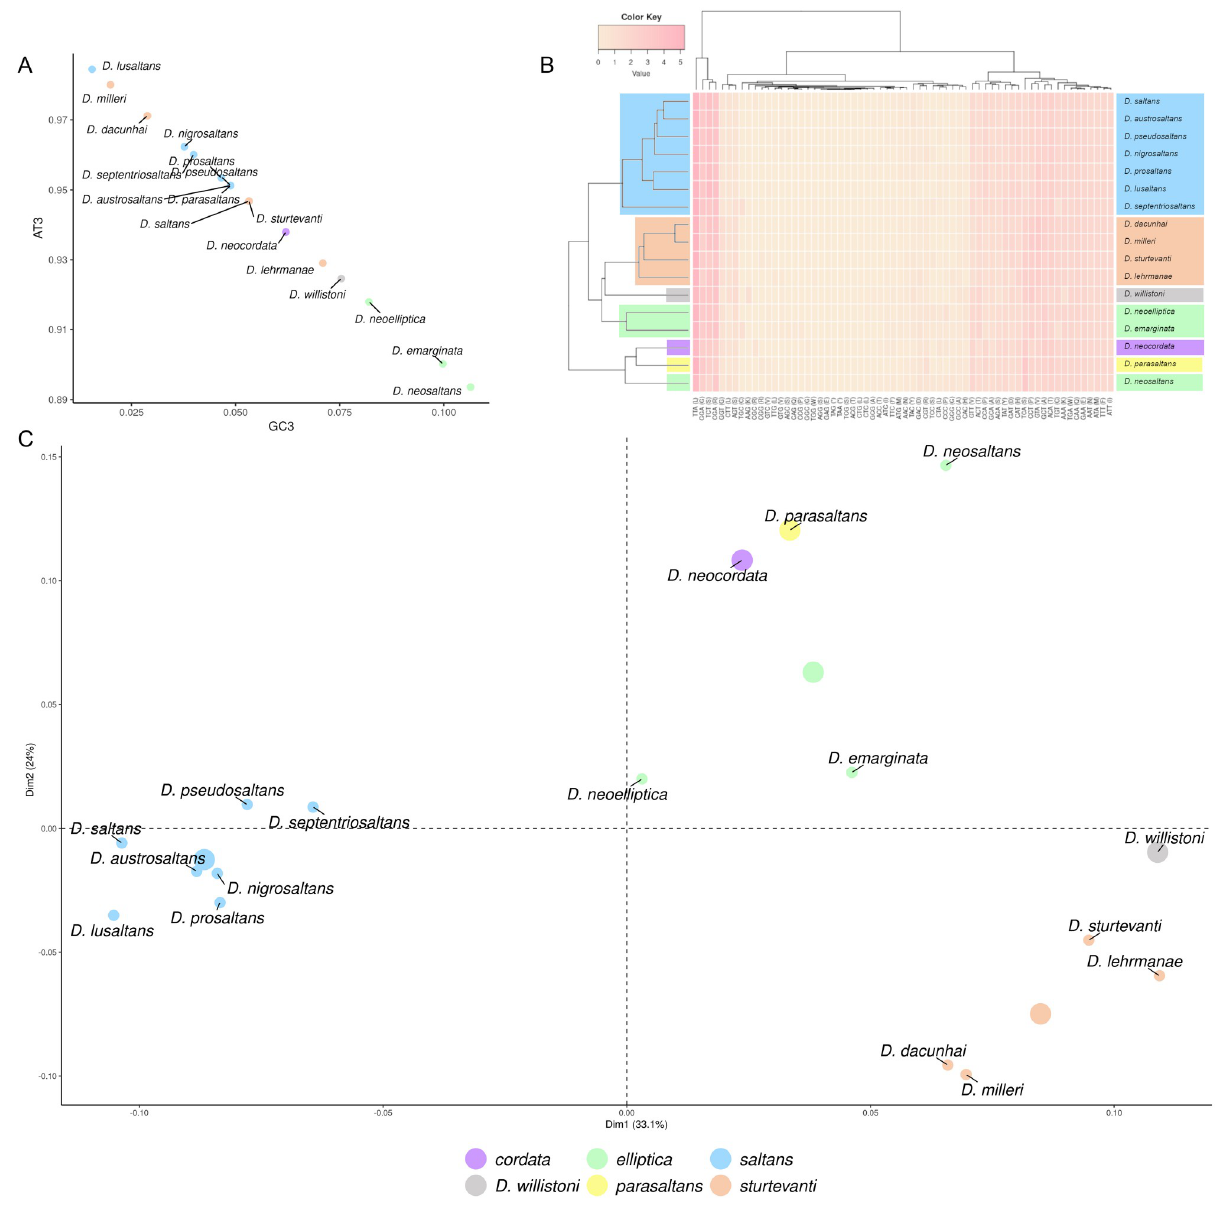
Fig 3. Codon usage bias pattern of mitochondrial genes COI and COII in the saltans group. (A) GC3 contents of saltans -group species. (B) Hierarchical clustering generated by heatmap. (C) Correspondence analysis of RSCU averages of 31 codons.